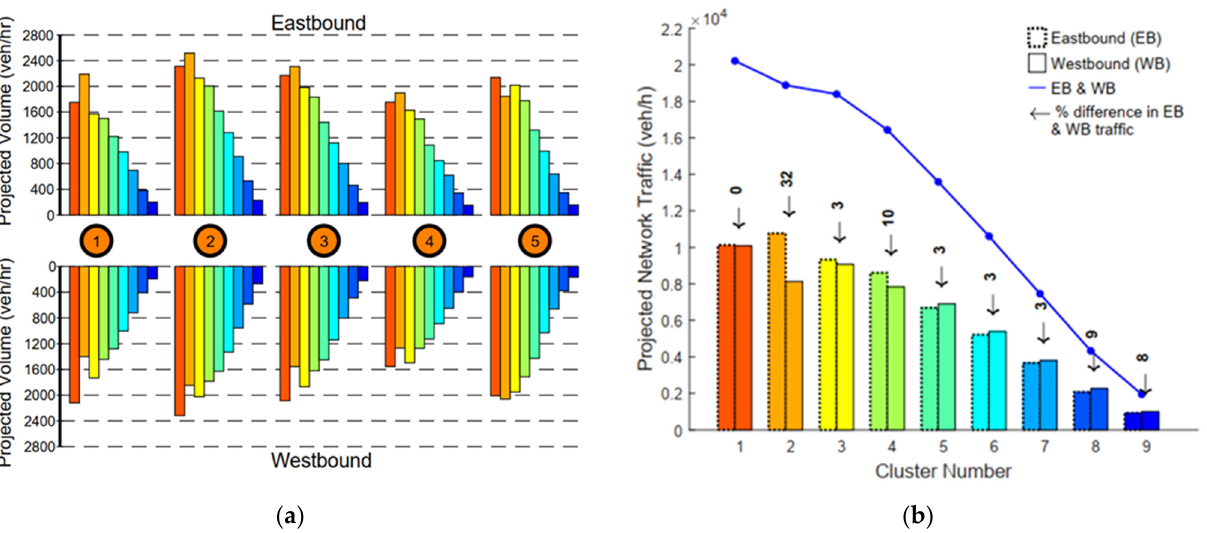
Figure 6. Spatial characteristics of projected volume profiles; ( a ) projected volume on each data collection site; ( b ) directional projected volume differences.